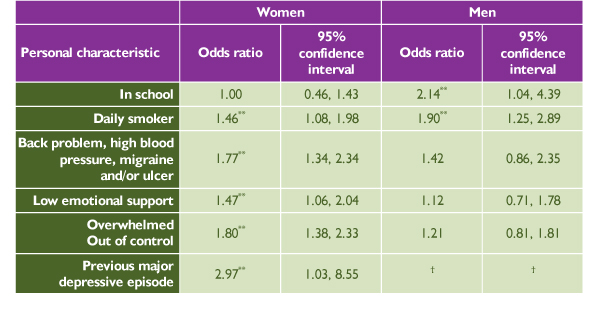
Adjusted odds ratio of a depressive episode* in 1996–1997 and/or 1998–1999, by selected characteristics in 1994–1995, Canada excluding territories Source: National Population Health Survey, longitudinal file, 1994–1995 to 1998–1999 (Health Rep 1999;11(3))